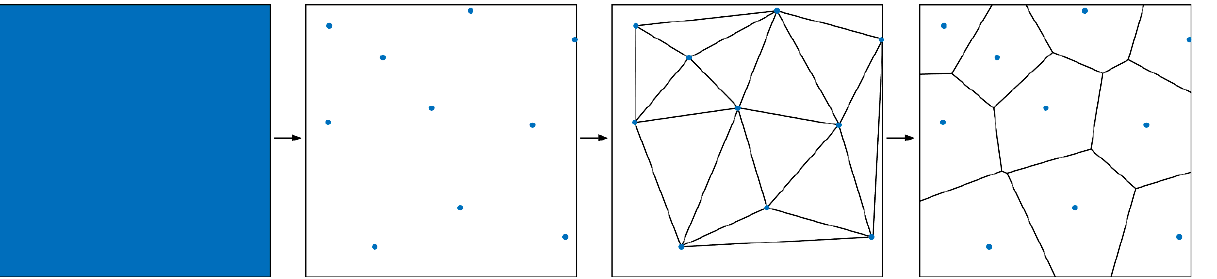
Figure 5. Overview for Voronoi